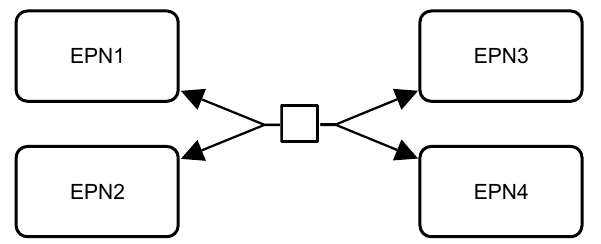
Figure 3.4: A valid reversible process. A process is reversible if its LHS and RHS contain only production